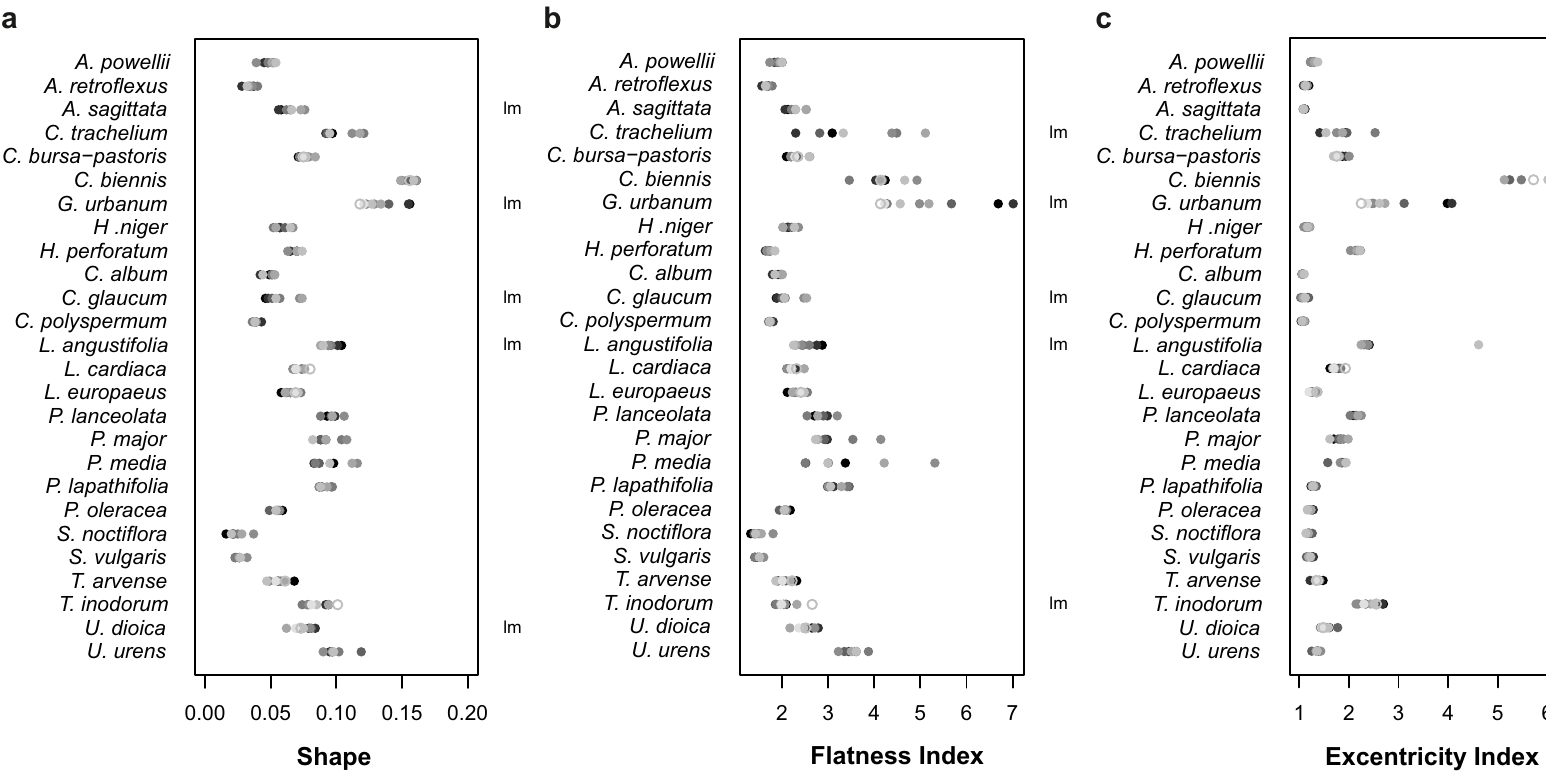
Figure 3. Variation in seed form with year after burial ( YAB ) for 26 species of seeds: ( a ) seed shape; ( b ) flatness index; ( c ) eccentricity index. The value of 0 indicates perfectly spherical seeds, while the value of 0.2 indicates flat or elongated seeds (Figure 3a). The larger the number the flatter (Figure 3b) or eccentric (Figure 3c) the seeds were. The decrease in the intensity of grey colour refers to the increase in YAB (i.e., a decrease in the intensity of grey colour): black = control, white with grey lining = YAB 8 are the two extremes). Lm (linear) indicates the cases when the change in the trait over time was significant according to the linear model. See Table 1 for generic names of each